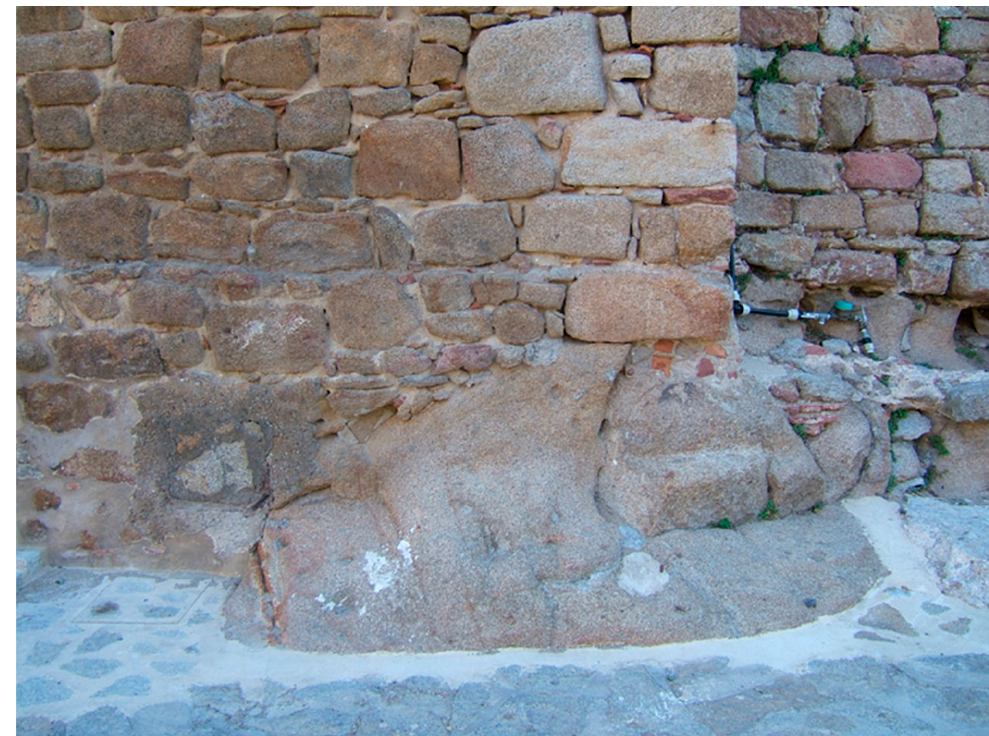
Figure 5. Detail of a granite ashlar masonry in which the intense chromatic alteration is evident (the rock changes from an overall grey colour to a "rust" colour) and the strong intergranular disintegration. Nine vertical alteration profiles distributed along the roads of the island were